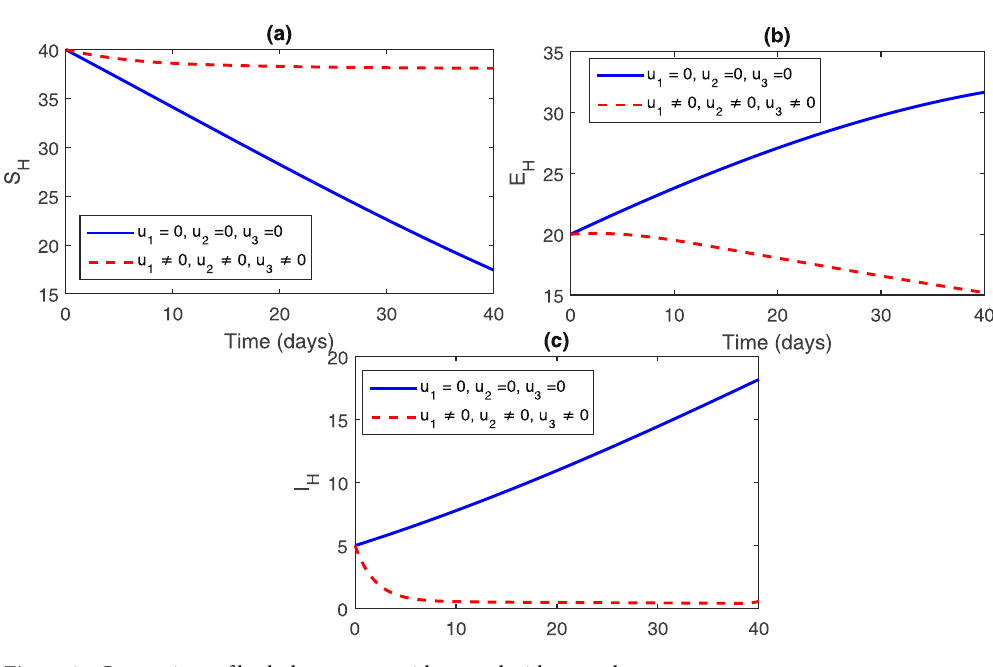
Figure 8. Comparison of both the systems: without and with